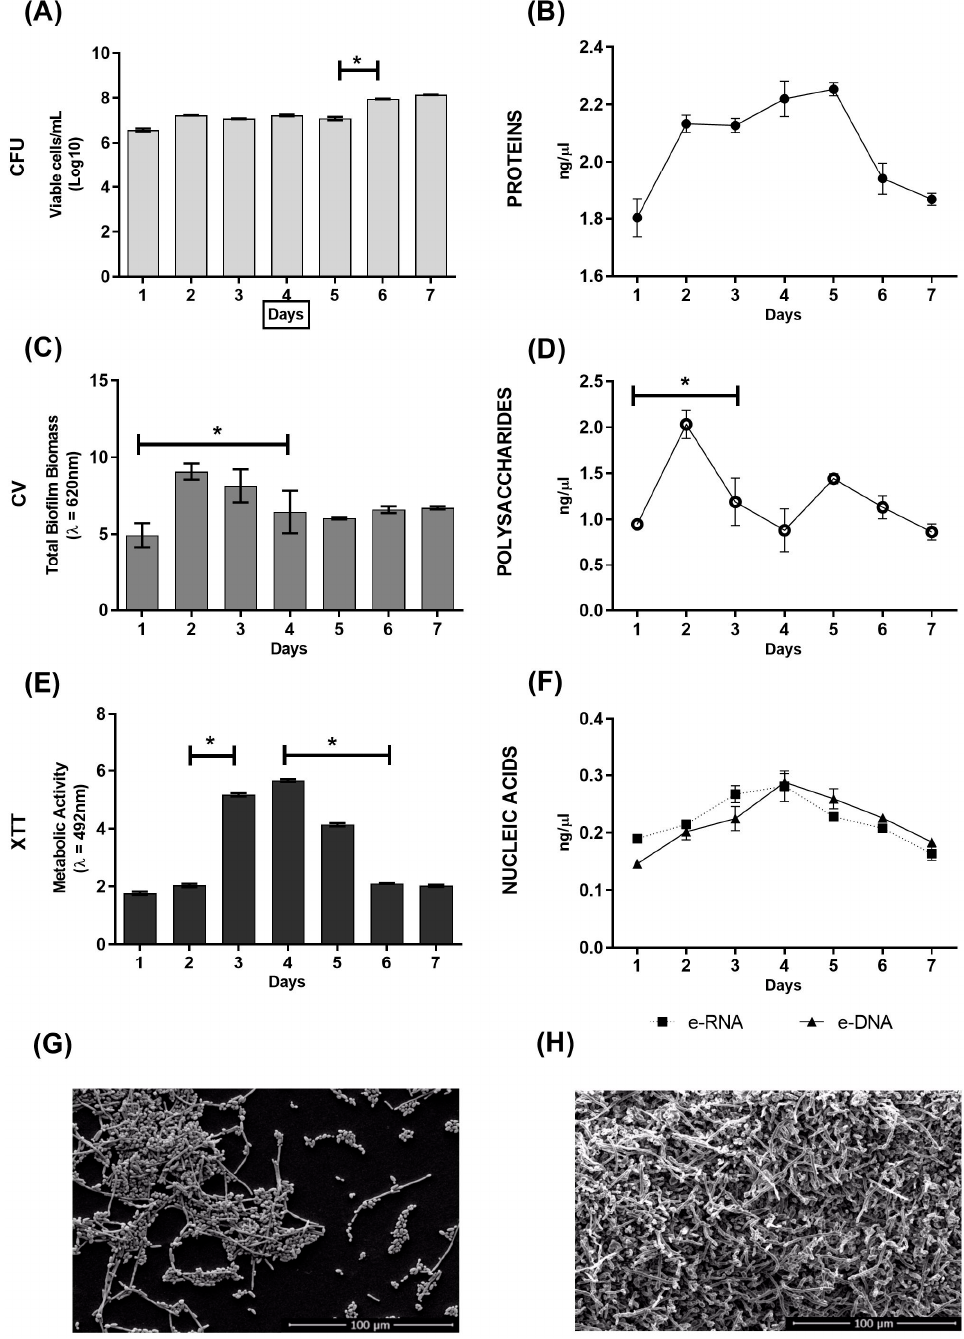
Figure 1. Dynamics of C. albicans biofilm formation on flat-bottomed polystyrene microplates over seven days. ( A ) Evaluation of cell viability by counting colony-forming units (CFU); ( B ) quantifi- cation of extracellular matrix (ECM) proteins; ( C ) quantification of total biomass by crystal violet (CV) staining; ( D ) quantification of ECM polysaccharides; ( E ) evaluation of metabolic activity by XTT reduction; ( F ) quantification of extracellular DNA (e-DNA) and e-RNA from the ECM; ( G ) morpho- logical characterization by scanning electron microscopy (SEM) of the one-day growth of C. albicans biofilm; ( H ) morphological characterization by SEM of the seven-day growth of C. albicans biofilm. * Statistical differences between consecutive days. Graphs show the mean ± SD of 2 repeats and are representative of 2 independent experiments. Scale bar = 100 μ m.